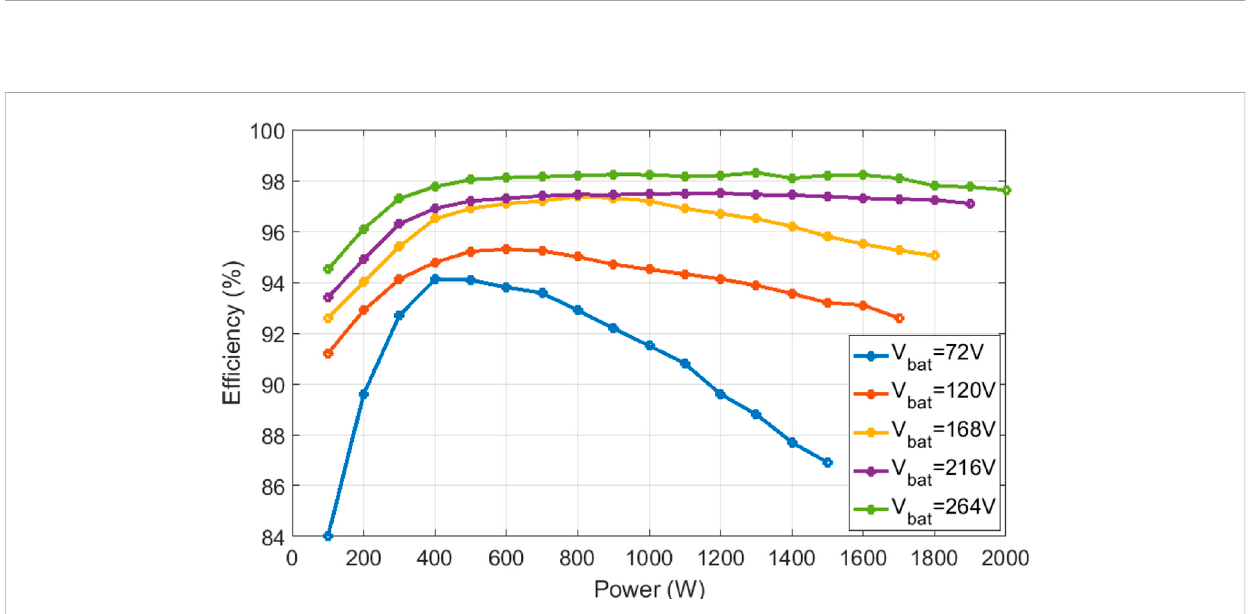
FIGURE 11 Ef fi ciency vs. power at different V bat for a Conventional Shunt charger